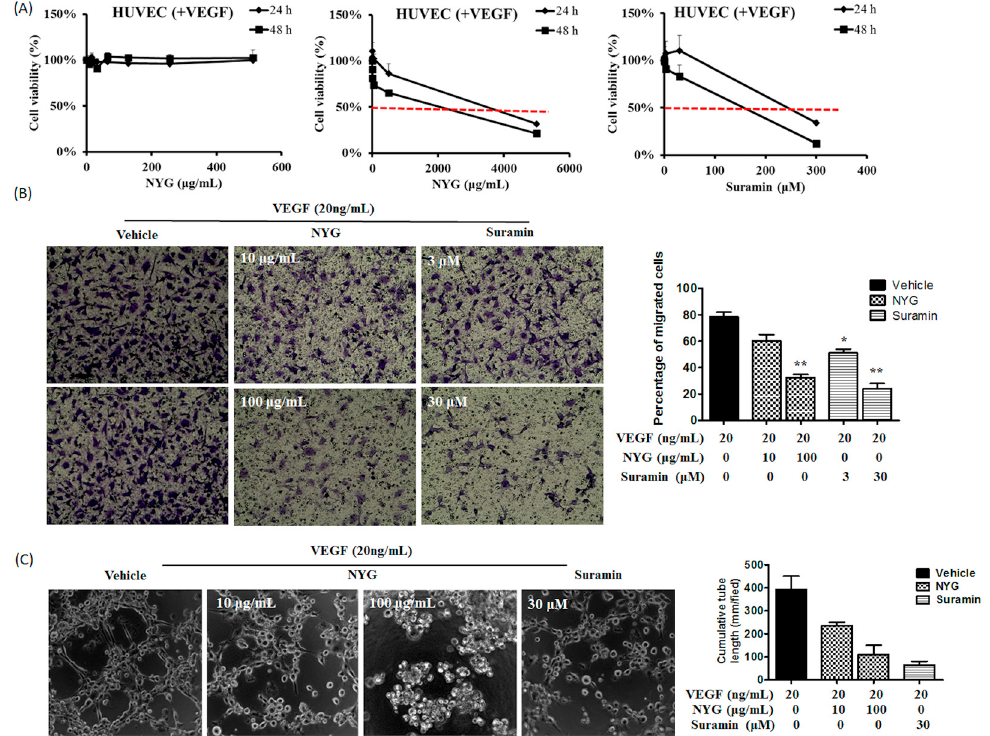
Figure 4. NYG reduced migration and tube formation of HUVEC cells. ( A ) HUVECs were treated with VEGF and serial doses of NYG and suramin for 24 and 48 h. Cell viability were measured as average of replicates ( n = 3) with standard deviation (%). The IC 50 of NYG on HUVEC is approximately 2 mg/mL and 4 mg/mL with incubation time of 24 and 48 h, respectively; ( B ) HUVECs were seeded on the upper chamber of transwell, either treated with VEGF (20 ng/mL) alone or in combination with NYG or suramin. The mean number of migrating cells was counted in five randomized fields per well under microscope. NYG treatment reduced invasive potential of HUVECs in dose dependent manner (40× magnification); ( C ) HUVECs were seeded on matrigel pre-coated well, either treated with VEGF (20 ng/mL) alone or in combination with NYG or suramin. The mean number of sprouts formed was counted in five randomized fields per well under microscope. NYG inhibited sprout formation of HUVECs in dose-dependent manner (100× magnification). * p < 0.05, ** p < 0.01.